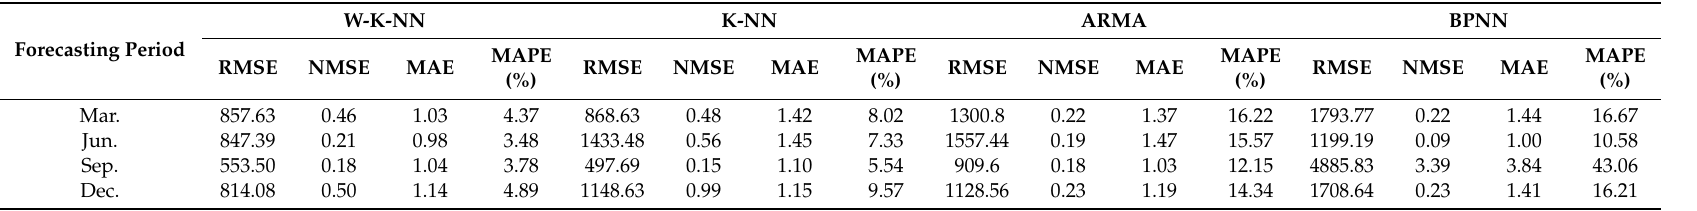
Table 6. Comparison of four forecasting models for the large sample (RMSE, NMSE, MAE and MAPE). Unit: MW.